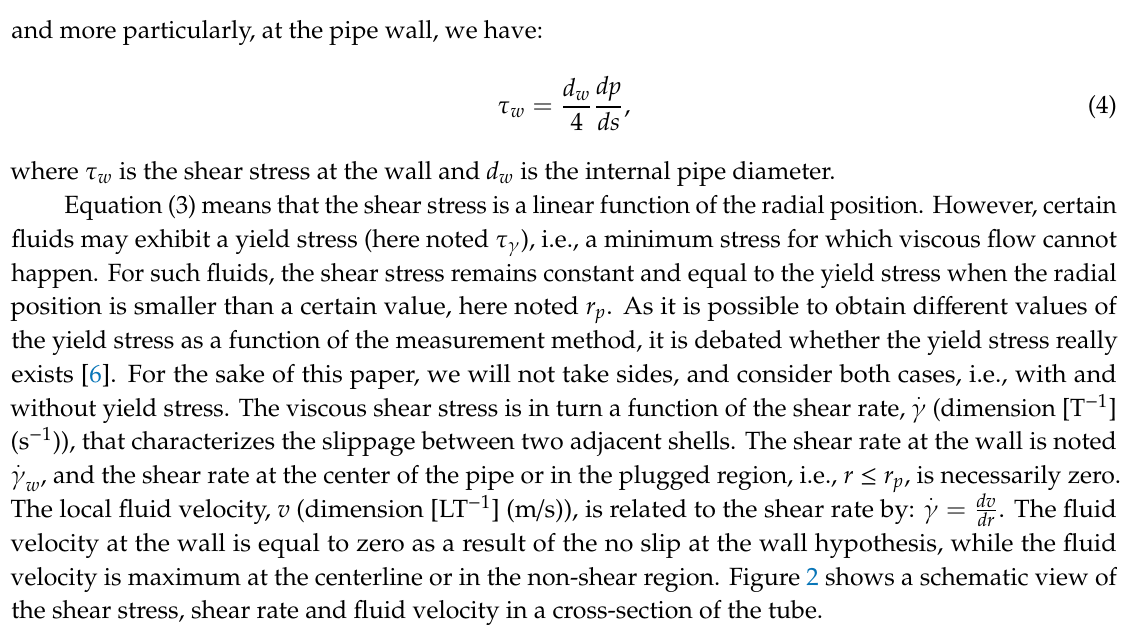
Figure 2. Schematic view of the shear stress, shear rate and velocity profiles in a cross-section.